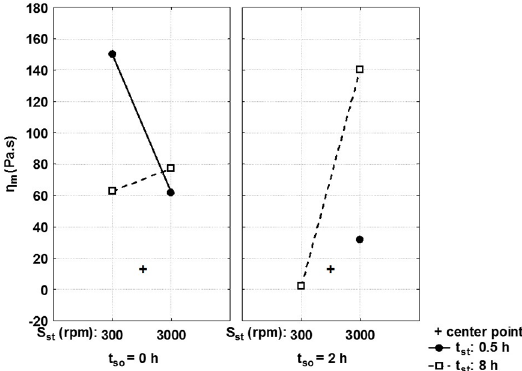
Figure 4. Means plot for maximum viscosity ηm . Symbols (+) are related to the center point average.